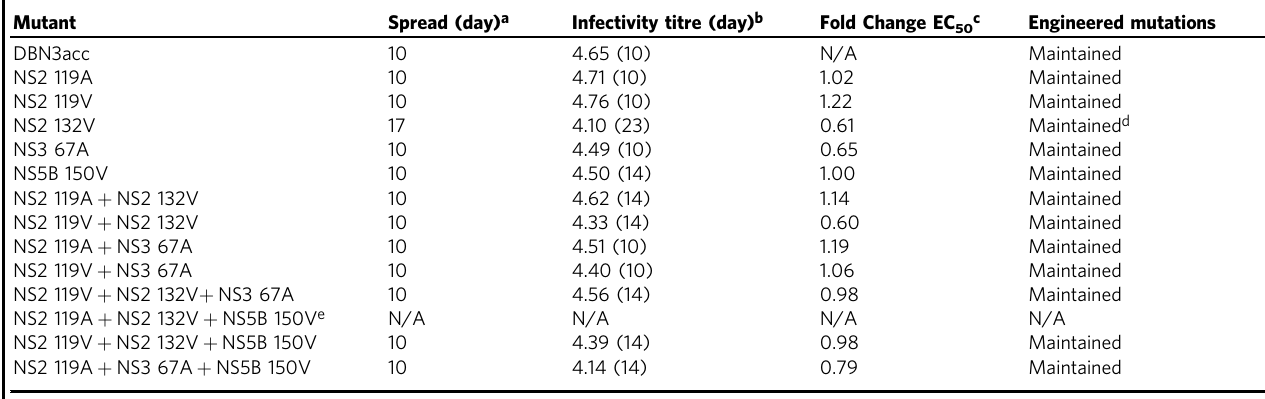
Table 2 Characteristics of HCV DBN3acc mutants after transfection and subsequent passage in Huh7.5 cells. Mutant